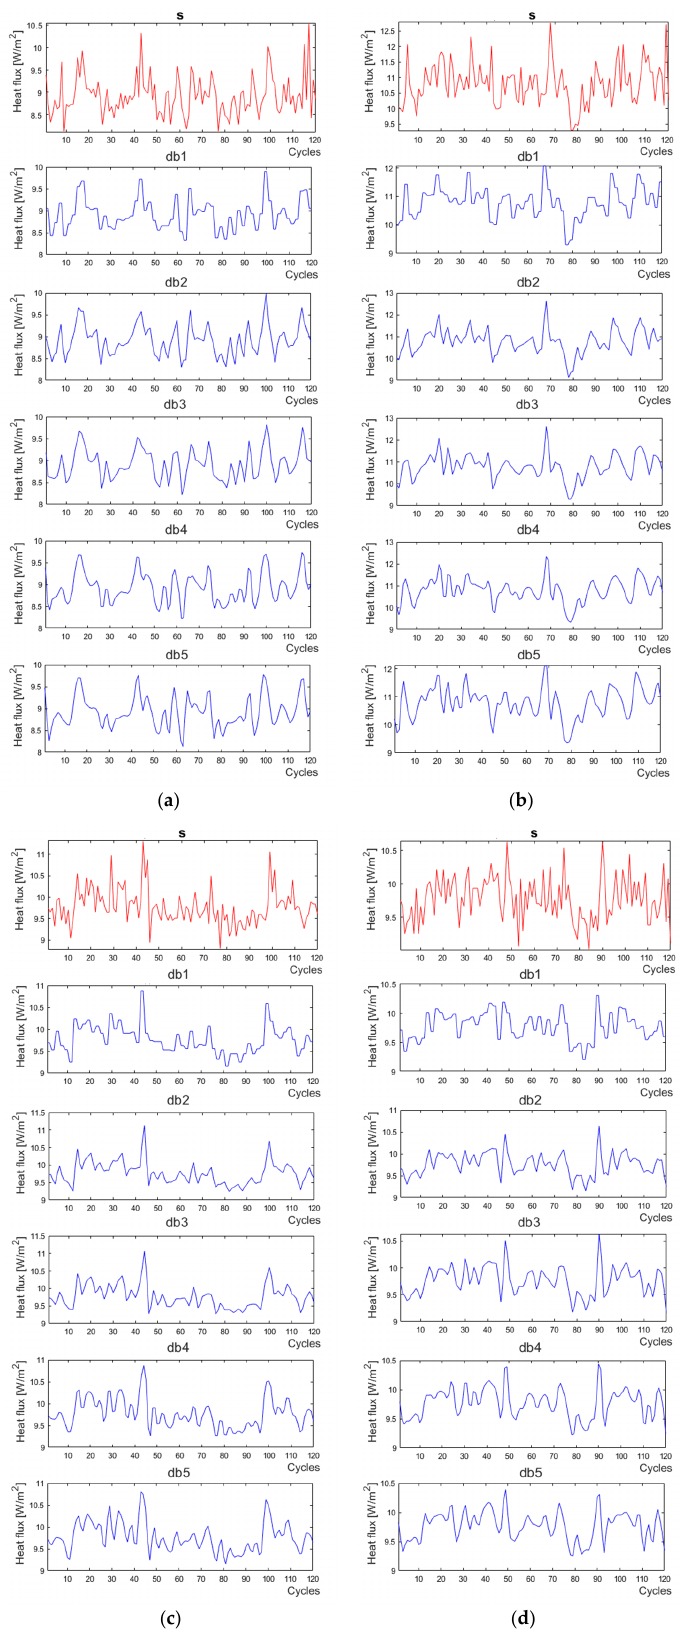
Figure 7. Signal ( s ) (red lines) and Daubechies 1–5 wavelets (blue lines) for the heat flux sensors: ( a ) q 9 , ( b ) q 10 , ( c ) q 11 , ( d ) q 12 .